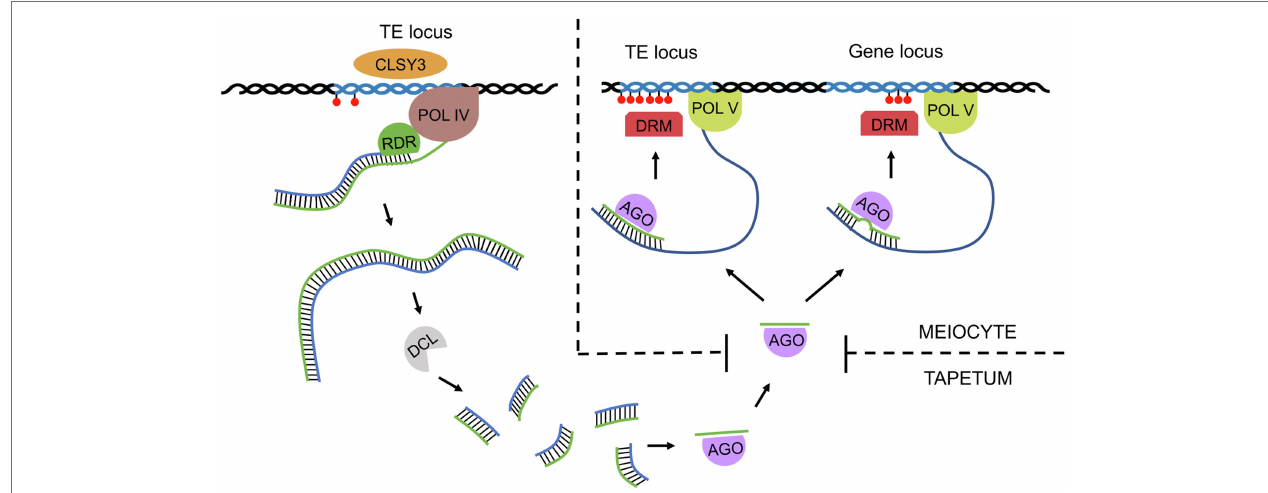
FIGURE 1 | A simplified model of siRNA function in male Arabidopsis meiosis. The reproductive tissue-specific chromatin remodeler CLASSY3 (CLSY3) recruits Pol IV to some transposons in tapetum cells. The resulting transcripts are converted into double-stranded RNA (dsRNA) by RDR polymerase and then sliced by Dicer- like endonuclease (DCL) into 24-nt siRNAs. Single-stranded siRNAs are then loaded onto an Argonaute (AGO) and transported to meiocytes. There, siRNAs bind to nascent Pol V products, inducing local DNA methylation (red circles) via DRM methyltransferase. siRNAs perfectly match the transcripts of transposons from which they derive; however, in the case of genes, siRNAs usually pair imperfectly, allowing mismatches. Such gene methylation is germline specific, which indicates an increased sensitivity of RdDM machinery in meiocytes compared to somatic